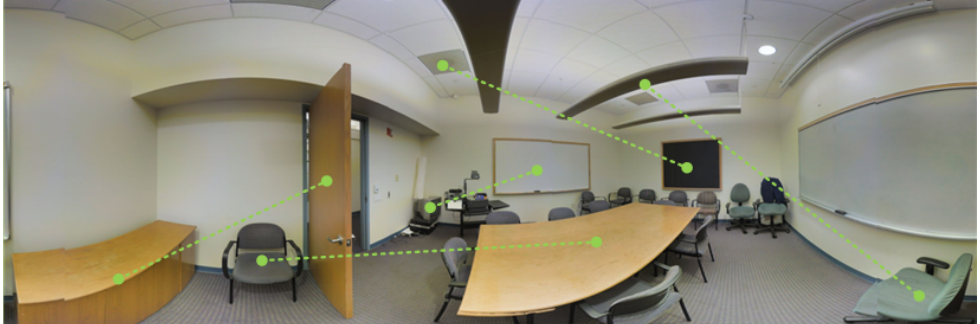
Figure 1. The relationships between objects and the room